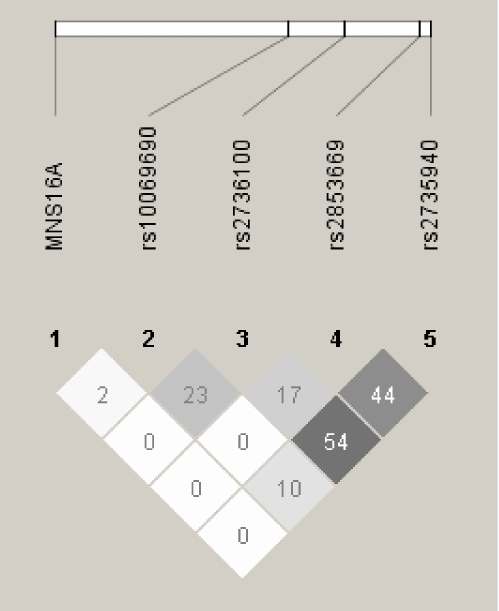
Figure 6. Analysis of linkage disequilibrium in patients with BC. Darker color shows higher r 2 values, while the value shown in the squares is r2 × 102. LD was considered to be medium for r 2 > 20 and strong for r 2 > 80. The chart was created using the Haploview 4.2